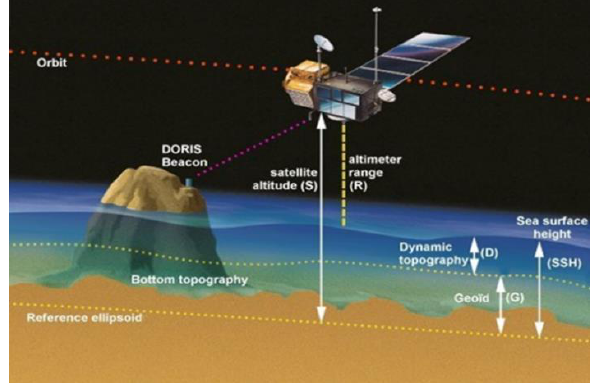
Figure 5. SSH determination from satellite altimetry